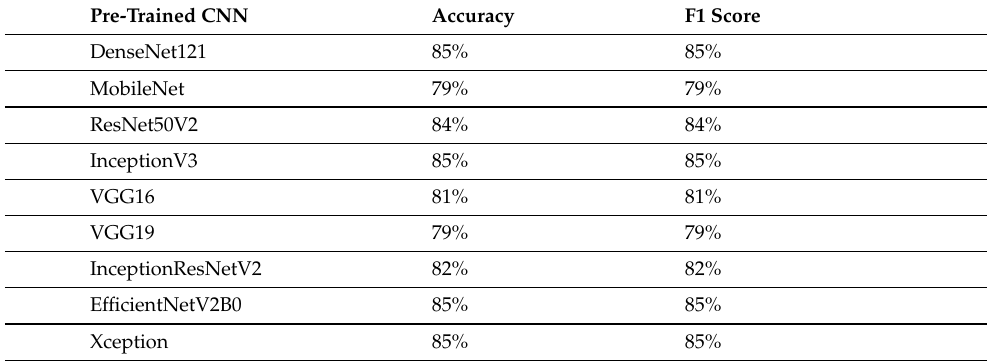
Table 14. Superclass classification.